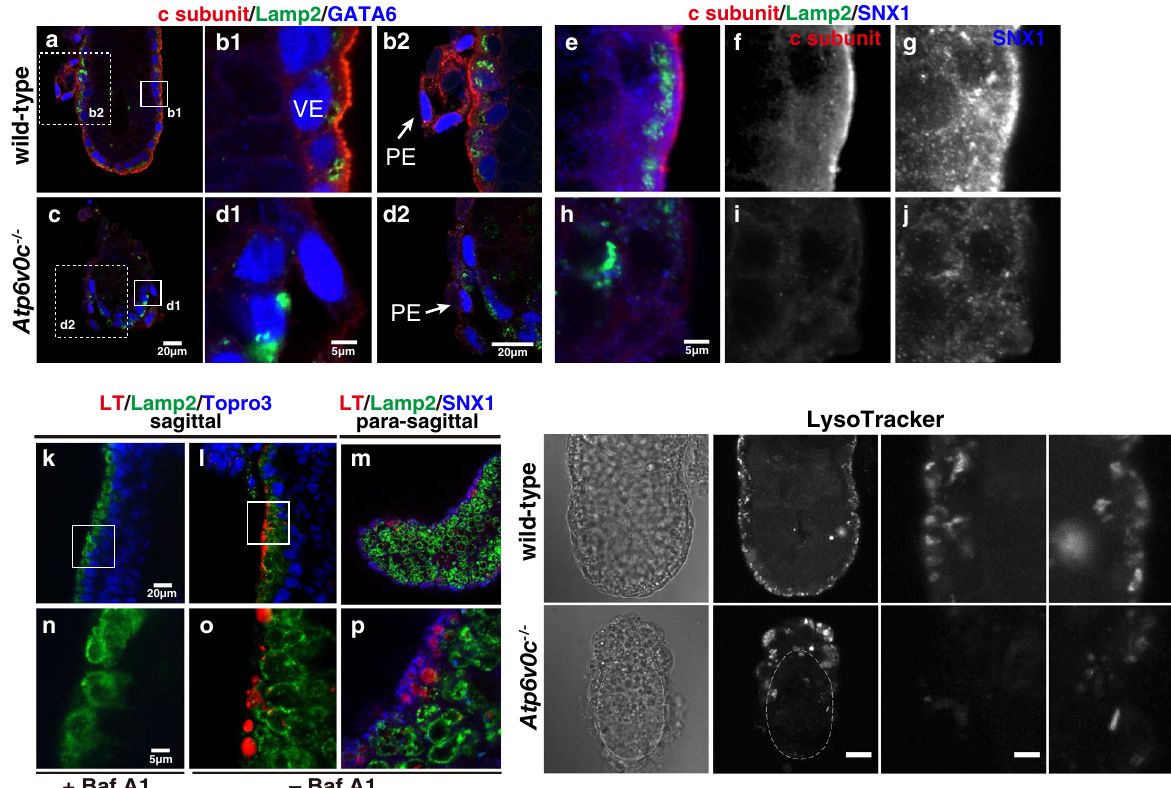
Figure 3. Acidification of intracellular compartments of E5.5 embryos required the c-subunit of V-ATPase. The signal of the c-subunit (red) (wild-type: n = 9, mutant: n = 12) accumulated at the apical region of VE cells in E5.5 embryos ( a to d ). Lamp2 (green) and GATA6 (blue) signals are also shown. The boxed areas of b1 and d1 are enlarged images showing the signals of c-subunit in VE cells, and the boxed region of b2 and d2 are those of PE cells (shown by the arrow). The c-subunit (red) signal overlapped with the early endosome marker, sorting nexin1 (SNX1) in E5.5 wild-type embryos (n = 3) ( e to g ). The localisation of SNX1 in mutant embryos appeared dispersed (n = 4) ( h to j ). VE, visceral endoderm; PE, parietal endoderm. The E6.0 wild-type embryos were labelled with LysoTracker (LT) in the presence ( k and n ) (n = 4) or absence of bafilomycin A1 (Baf A1) (n = 14) ( l , m , o , and p ). The sagittal images (LT in red, Lamp2 in green, and Topro3 in blue) and para-sagittal images (LT in red, Lamp2 in green, and SNX1 in blue) are shown. The signal of LysoTracker was surrounded by the signal of SNX1 ( m and p ). LysoTracker staining of E5.5 wild-type (n = 17) ( q and r ) and Atp6v0c mutant embryos (n = 3) ( s and t ). The boxed regions in r and t are enlarged, and scale bars in panels a, c, b2, d2,